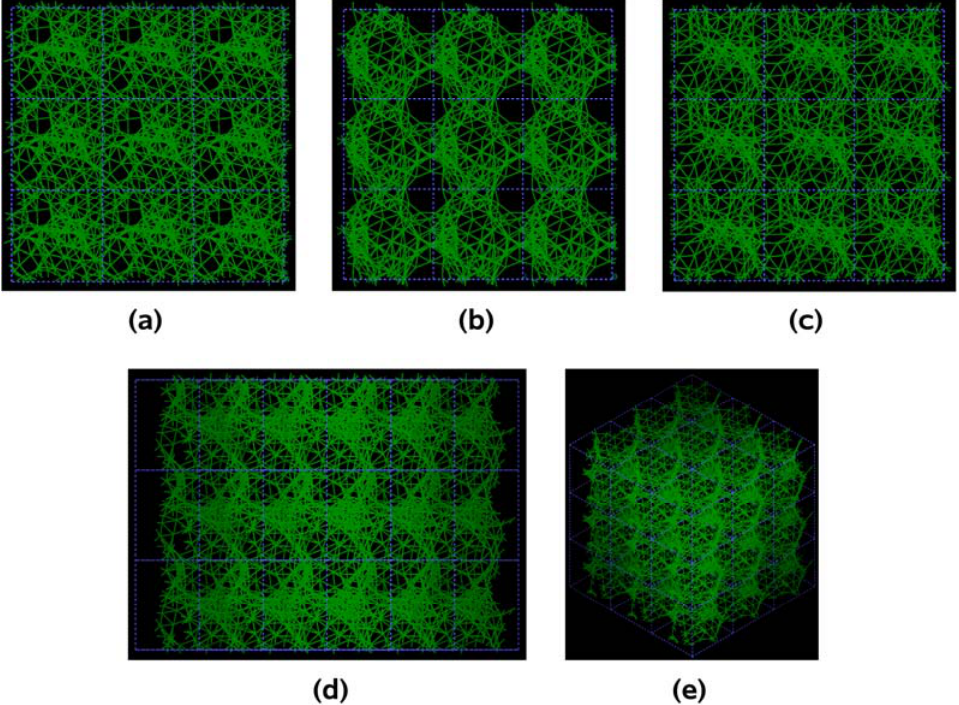
Figure 25. Pores formed in a 3 × 3 × 3 50% porosity, 108-gold atom supercell when it undergoes an MD process at 300 K during 500 steps. There are through pores along the (b) y direction, and a tendency to through pore formation along all the other